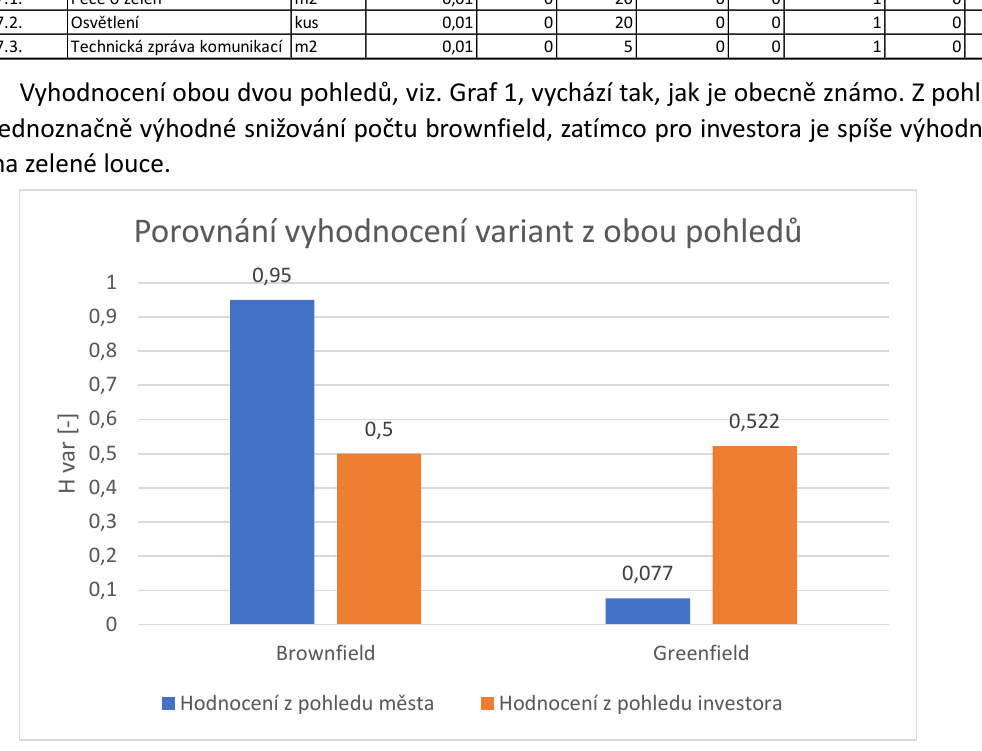
Graf 1: Porovnání vyhodnocení variant z pohledů investora a města. zdroj: